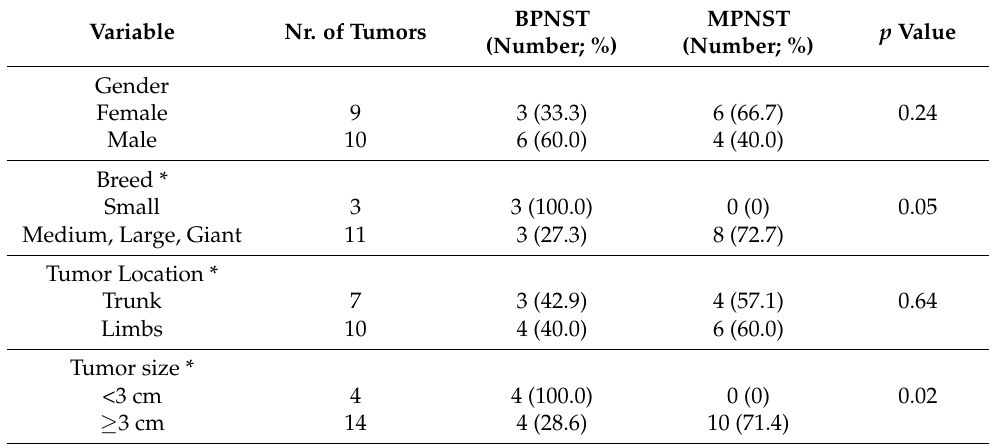
Table 2. Relationship between tumor type and clinicopathological variables in canine PNST.